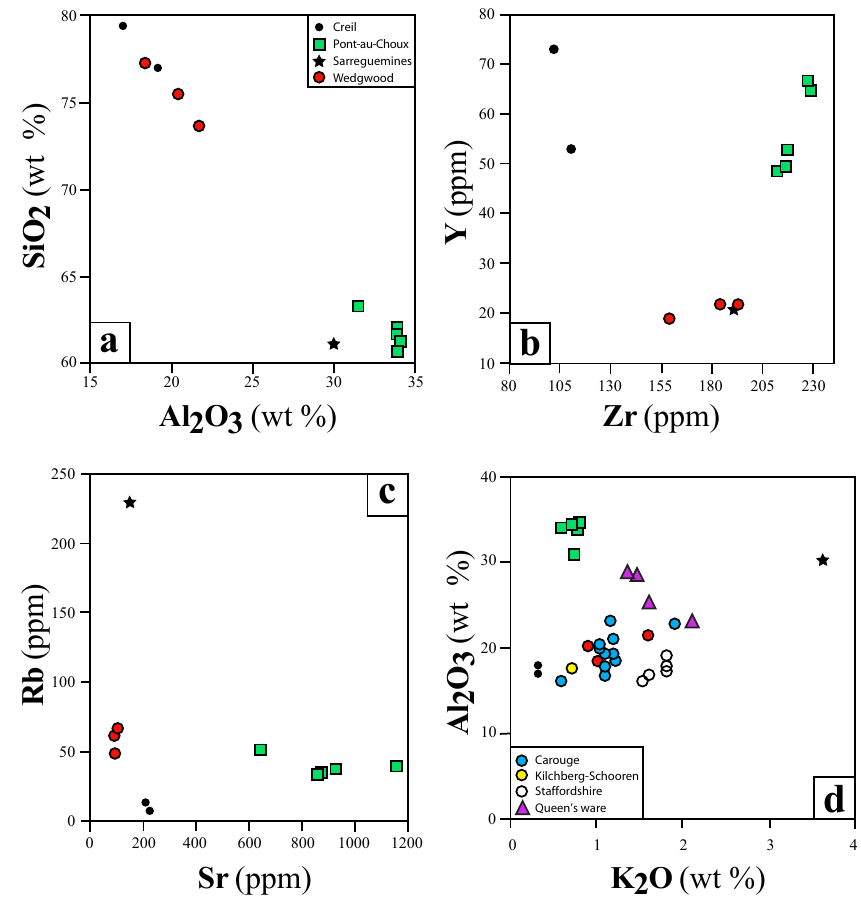
Figure 7. Body (bulk) compositions (XRF analyses) for the English and French CaO-poor samples displayed on three selected binary diagrams: ( a ) SiO 2 -Al 2 O 3 , ( b ) Y-Zr and ( c ) Rb-Sr plot from [16]. ( d ) Al 2 O 3 -K 2 O diagram with the samples as in Figure 7a–c, completed with more European CaO-poor white earthenwares from Carouge [37], Kilchberg-Schooren [58], Staffordshire [44] and French & Belgian Queen’s ware types ( faïence feldspathique )